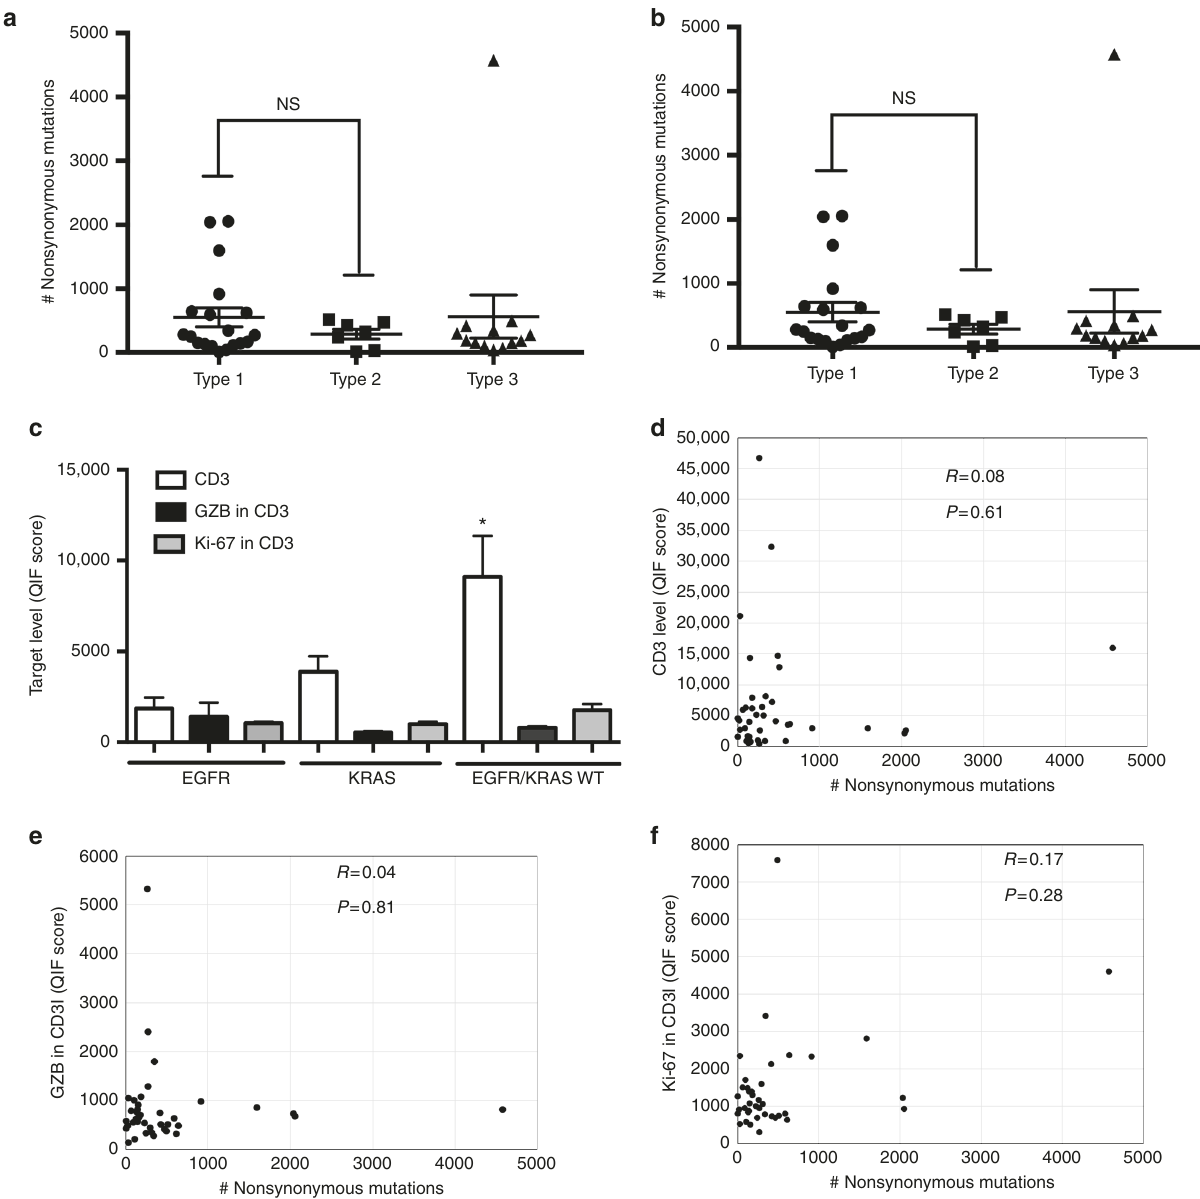
Fig. 7 Association between mutations and tumor immune in fi ltration and proliferation and cytolytic activity in NSCLC. a , b Association between the mutational load ( a ) or predicted class-I neoantigens ( b ) and speci fi c TIL patterns found in lung tumors from patients treated with immune checkpoint blockers. NS = not signi fi cant with Mann – Whitney P > 0.05. c Chart showing the level of CD3 (white bars), T-cell GZB (black bars), and T-cell Ki-67 (gray bars) in lung tumors from patients treated with immune checkpoint blockers harboring mutations in EGFR ( N = 8), KRAS ( N = 11) or lacking mutations in both oncogenes ( N = 30). Error bars indicate S.E.M. * P < 0.05; NS = not signi fi cant ( P > 0.05), Mann – Whitney test. d , f Association between the mutational load and the level of CD3 ( d ), T-cell GZB ( e ), and T-cell Ki-67 ( f ) in lung cancer patients treated with immune checkpoint blockers. R = Spearman ’ s correlation coef fi cient. The P value for the correlation is indicated within each